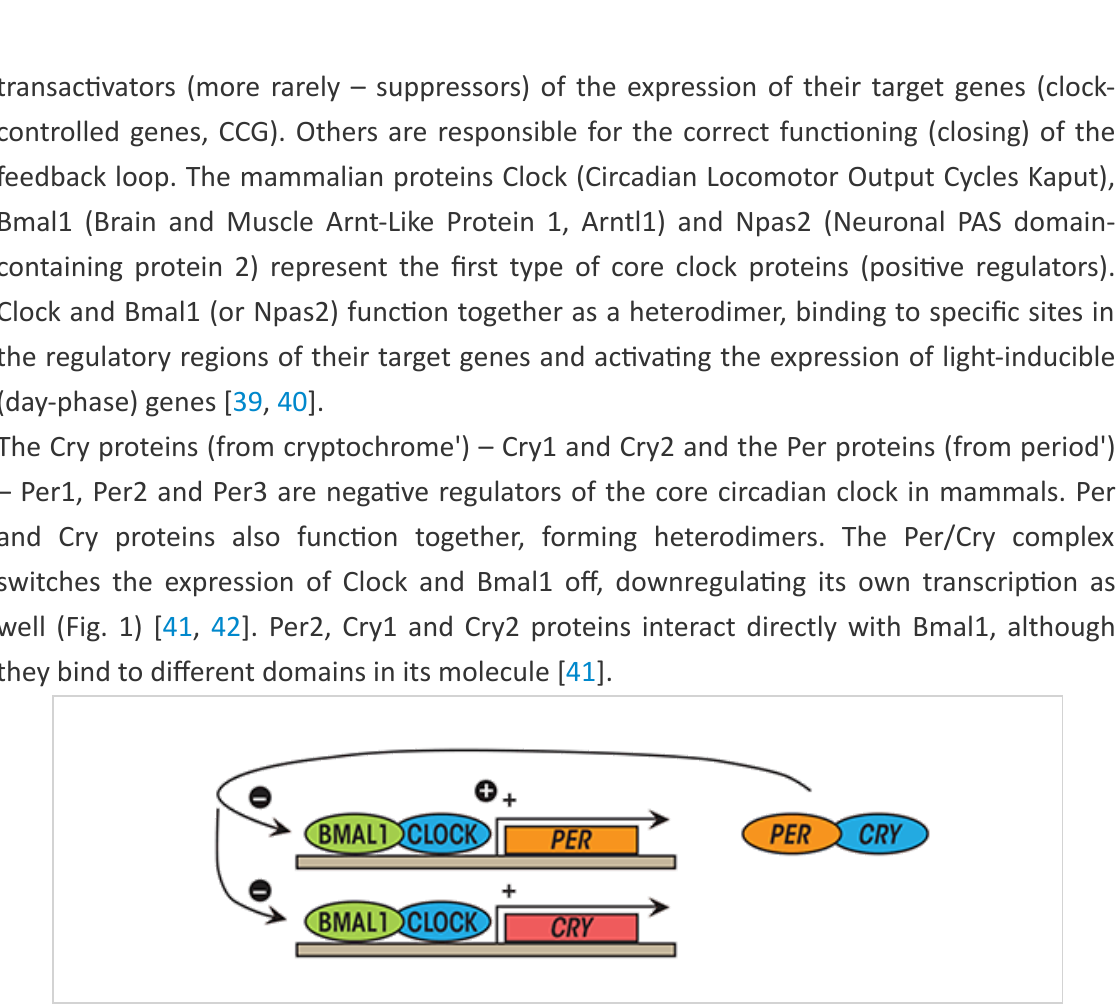
Figure 10. Core feedback loop of the circadian clock in mammals